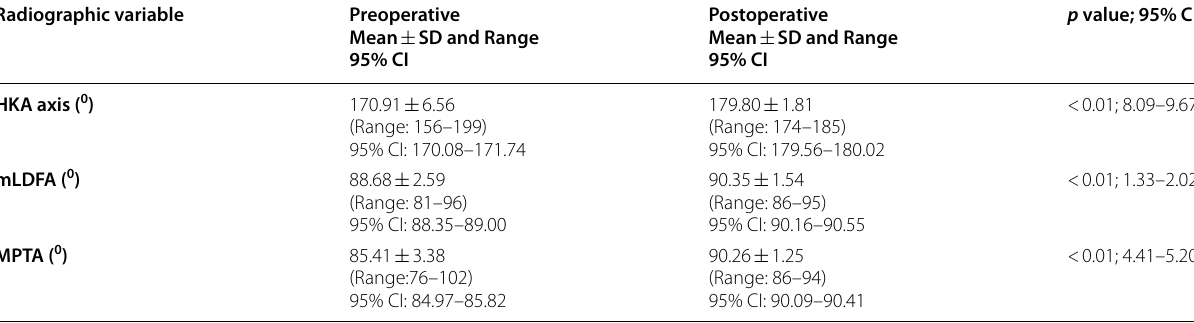
Table 2 Pre- and postoperative primary outcome variables (Radiographic